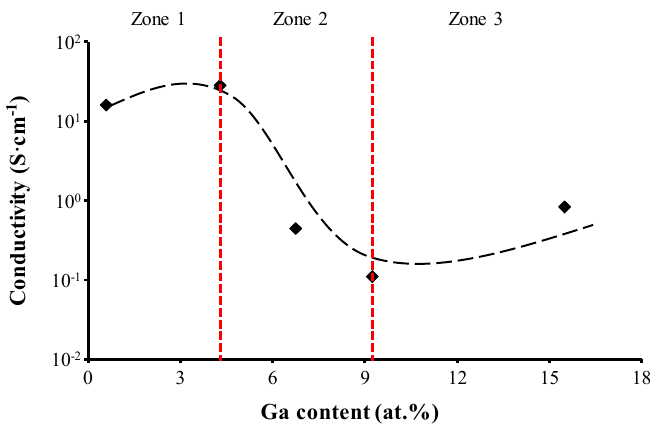
Figure 4. The variation in film conductivity as a function of Ga content in ZnO films. The variation in the carrier concentration in the films with increasing Ga concentration was analyzed via Hall measurement, and the results are shown in Figure 5. The carrier concentration exhibited a trend similar to that of the film’s conductivity and revealed the formation and development of neutralized gallium species. When the Ga content was relatively low (Zone 1), most gallium atoms were ionized and replaced Zn 2+ cations. Free electrons were derived from this replacement. Thus, the carrier concentration increased with rising gallium content. In Zone 2, the carrier concentration decreased due to an increasing number of gallium atoms separating from the ZnO lattice and forming neutral defects, which did not contribute to the generation of free electrons.